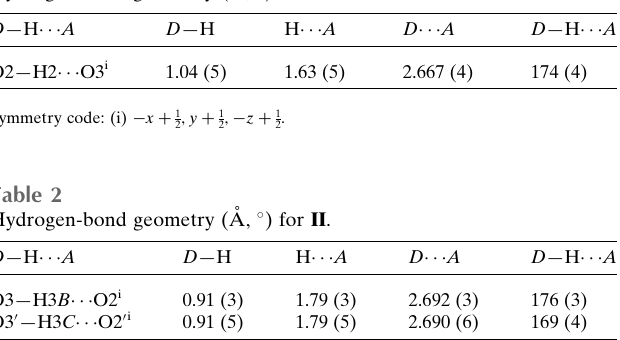
Table 1 Hydrogen-bond geometry (A˚ , (cid:2) ) for I .